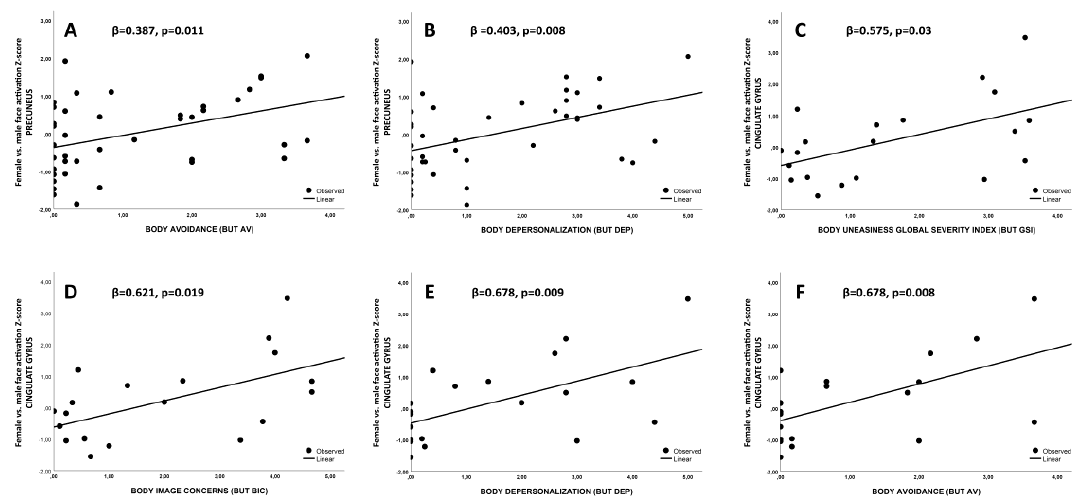
Figure 5. Association between precuneus and posterior cingulate gyrus ROI Z-scores with body uneasiness test-related scales ( A,B and C – F , respectively). ROI= region of interest.